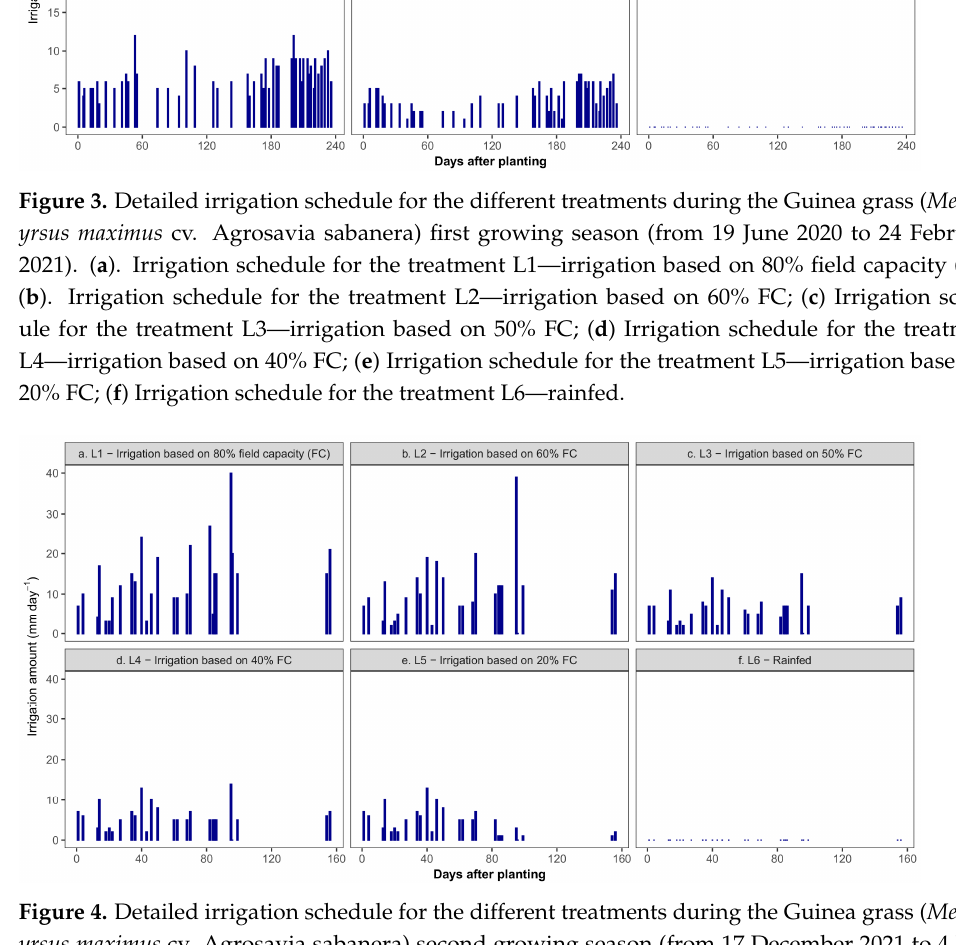
Figure 4. Detailed irrigation schedule for the different treatments during the Guinea grass ( Mega ‐ thyrsus maximus cv. Agrosavia sabanera) second growing season (from 17 December 2021 to 4 June